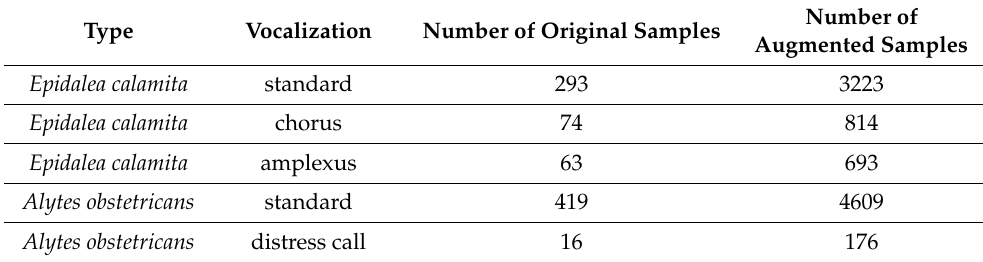
Figure 9. Stages in the classification system.